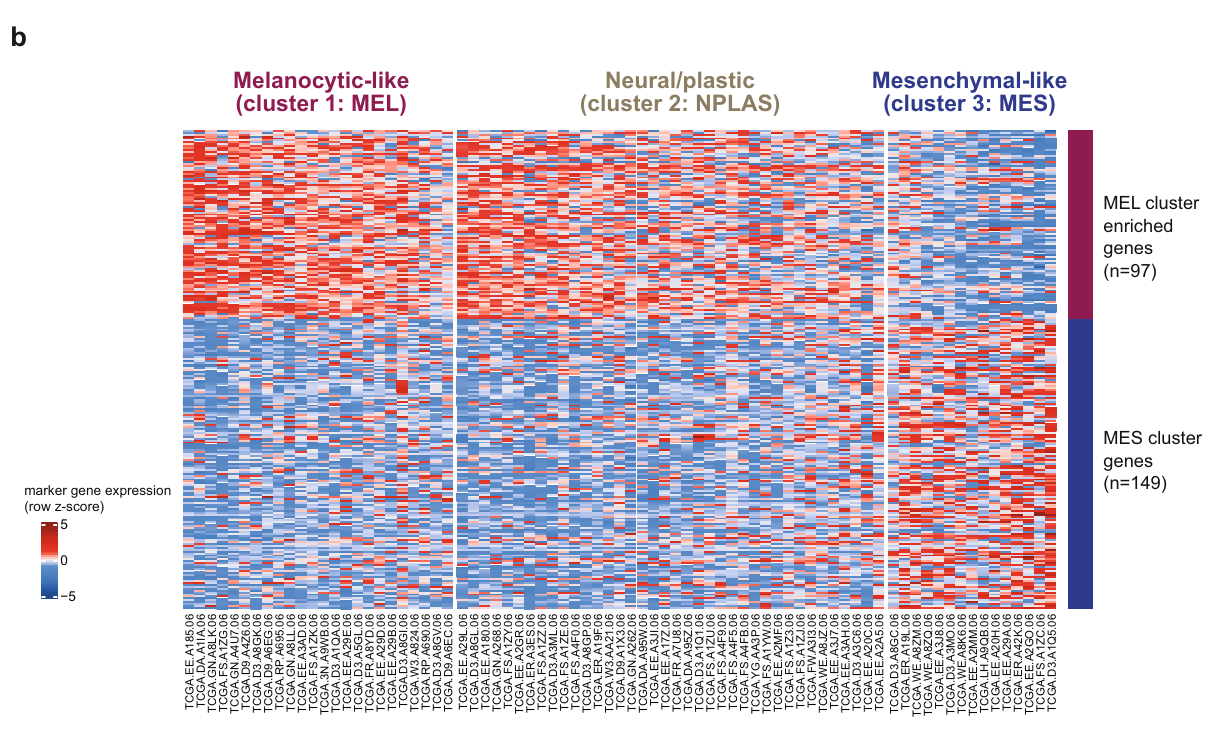
Fig. 1 Differentially expressed genes between MEL and MES clusters. Genes that were differentially expressed ( p < 0.05) between MEL and MES samples. a Early passage melanoma MDACC cell lines ( n = 53, see also Supplementary Fig. 2b, d). b High-purity metastatic TCGA melanoma samples ( n = 77, purity = 0.85 by ABSOLUTE and/or CPE) with cluster assignments by cNMF clustering based on MEL and MES gene expression (one MEL